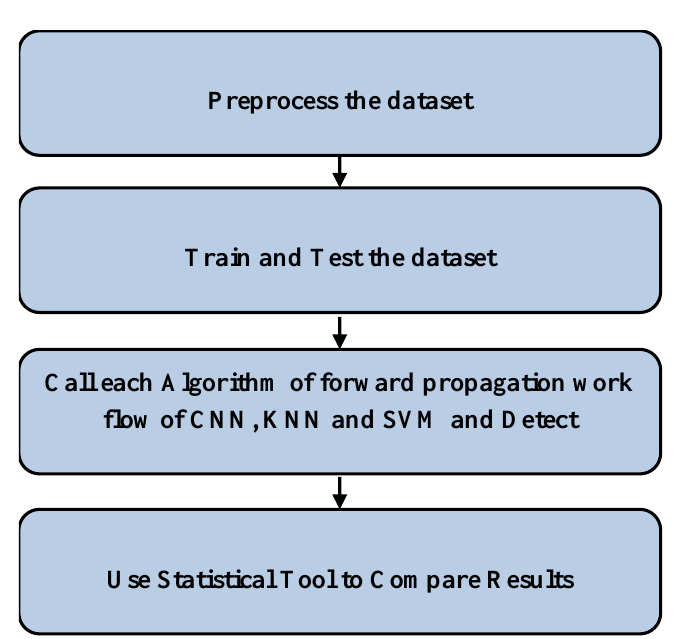
Figure 1. Malicious information detection steps.